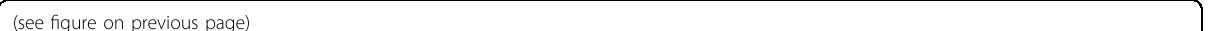
Fig. 4 CDKN2B-AS1 regulates NUF2 transcription by acting as a modular scaffold of CBP and SMYD3 complex to affect H3K27ac and H3K4me3 modi fi cation. a qRT-PCR subcellular analysis of CDKN2B-AS1 in 769-P and ACHN cells, U3 and GAPDH acted as nucleus and cytoplasm markers, respectively. b ChIP-seq analysis of H3K27ac and H3K4me3 enrichment at the NUF2 promoter region in normal renal tissues, KIRC tissues, and tumor tissue-derived primary cells. c , f ChIP analysis of H3K27ac and H3K4me3 ( c ), and the chromatin-modifying enzymes CBP and SMYD3 ( f ) enrichment in the NUF2 gene promoter; ChIP enrichment was measured using real-time PCR, normalized by the input DNA. d , e 769-P and ACHN cells were transfected with the si-CDKN2B-AS1 mix for 48 h; ChIP analysis of H3K27ac, H3K4me3, and H3K27me3 ( d ), and the chromatin-modifying enzymes P300, CBP, and SMYD3 ( e ) enrichment in the NUF2 gene promoter; ChIP enrichment was measured using real-time PCR, normalized by the input DNA. g , h qRT-PCR and western blot analysis of CBP, SMYD3, and NUF2 mRNA and protein expression in 769-P and ACHN cells transfected with si-CBP ( g ) and si-SMYD3 ( h ) for 48 h, respectively; β -actin or GAPDH was used as the internal control, respectively. i RIP assay analysis of CBP and SMYD3 enrichment in CDKN2B-AS1 in 769-P and ACHN cells; RIP enrichment was measured using qRT-PCR normalized by the input RNA. Error bars represent the SEM from three independent experiments, ** p < 0.01 vs. IgG or si-NC, * p < 0.05 vs. IgG or si-NC. P value calculated by independent sample t test ( d , e , g , h ), one-way ANOVA, and Dunnett multiple comparison test ( c , f , i ). TSS transcription start